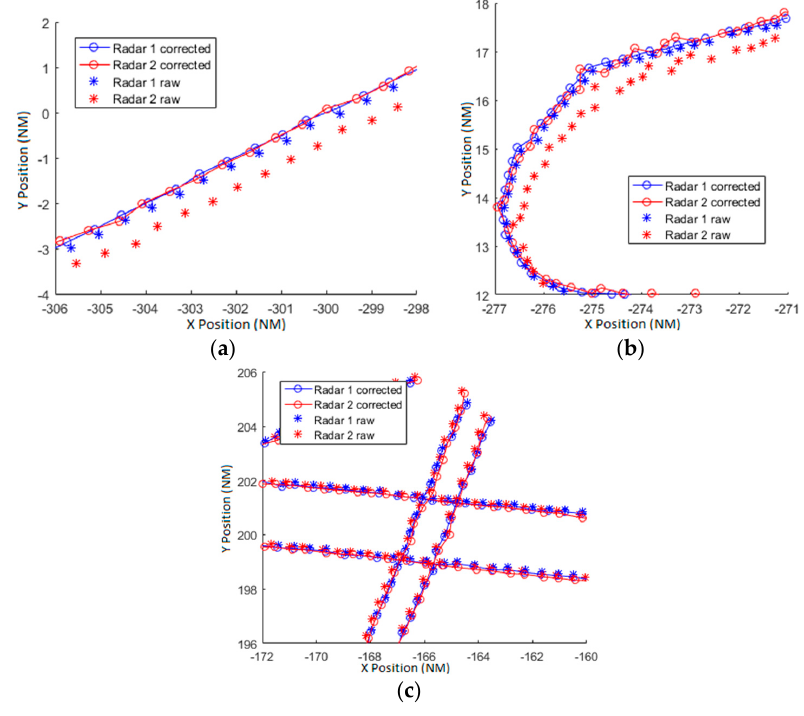
Figure 18. ( a ) Straight trajectory ( b ) Take off trajectory corrected with basic model ( c ) Several trajectories allocated at the upper-right corner of the scenario corrected with the complete model.